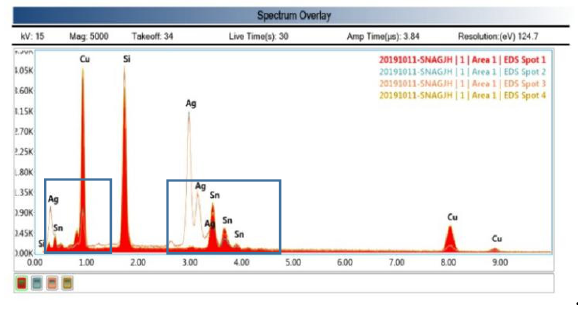
Figure 11. ESD spectrum.